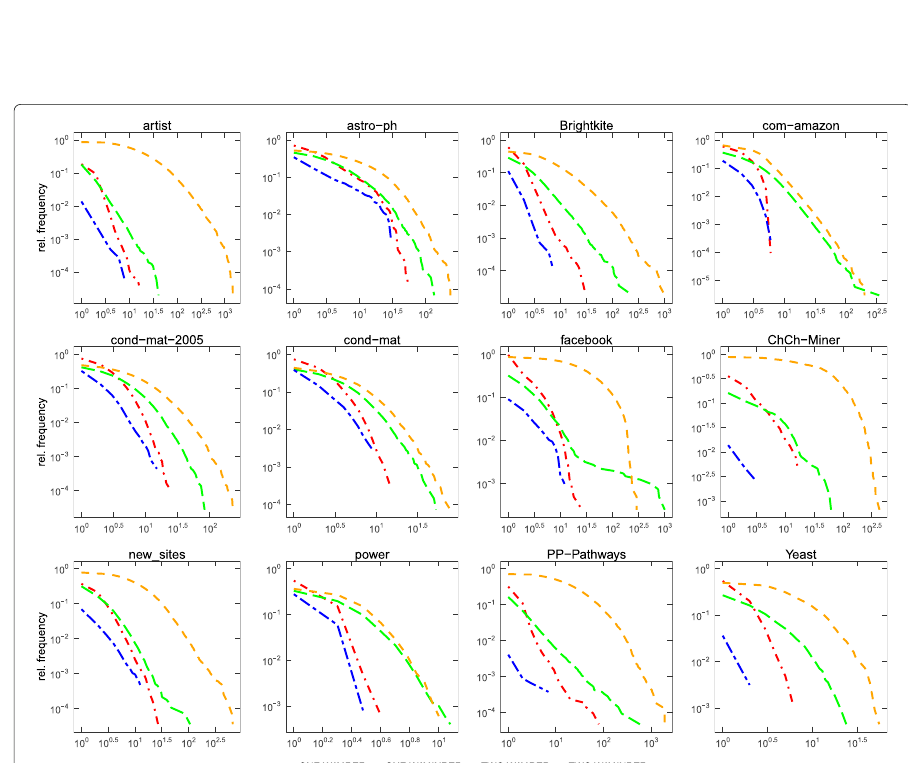
Fig. 22 Dependency properties in real-world